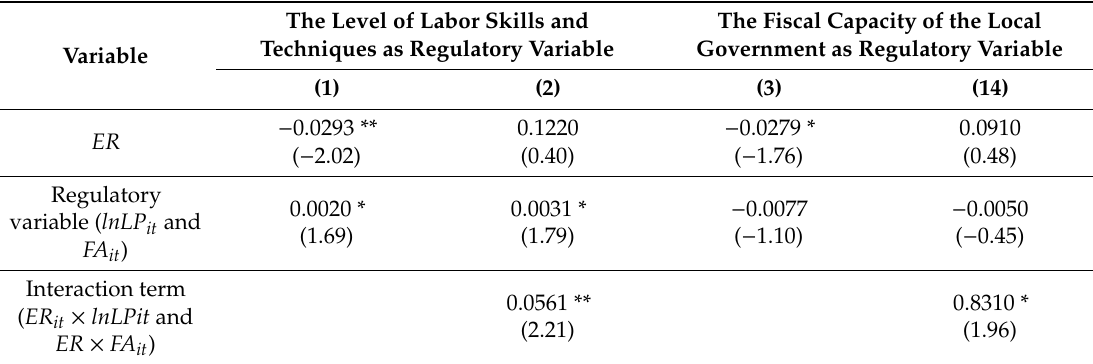
Table 4. Robustness test results based on System Generalized Method of Moments